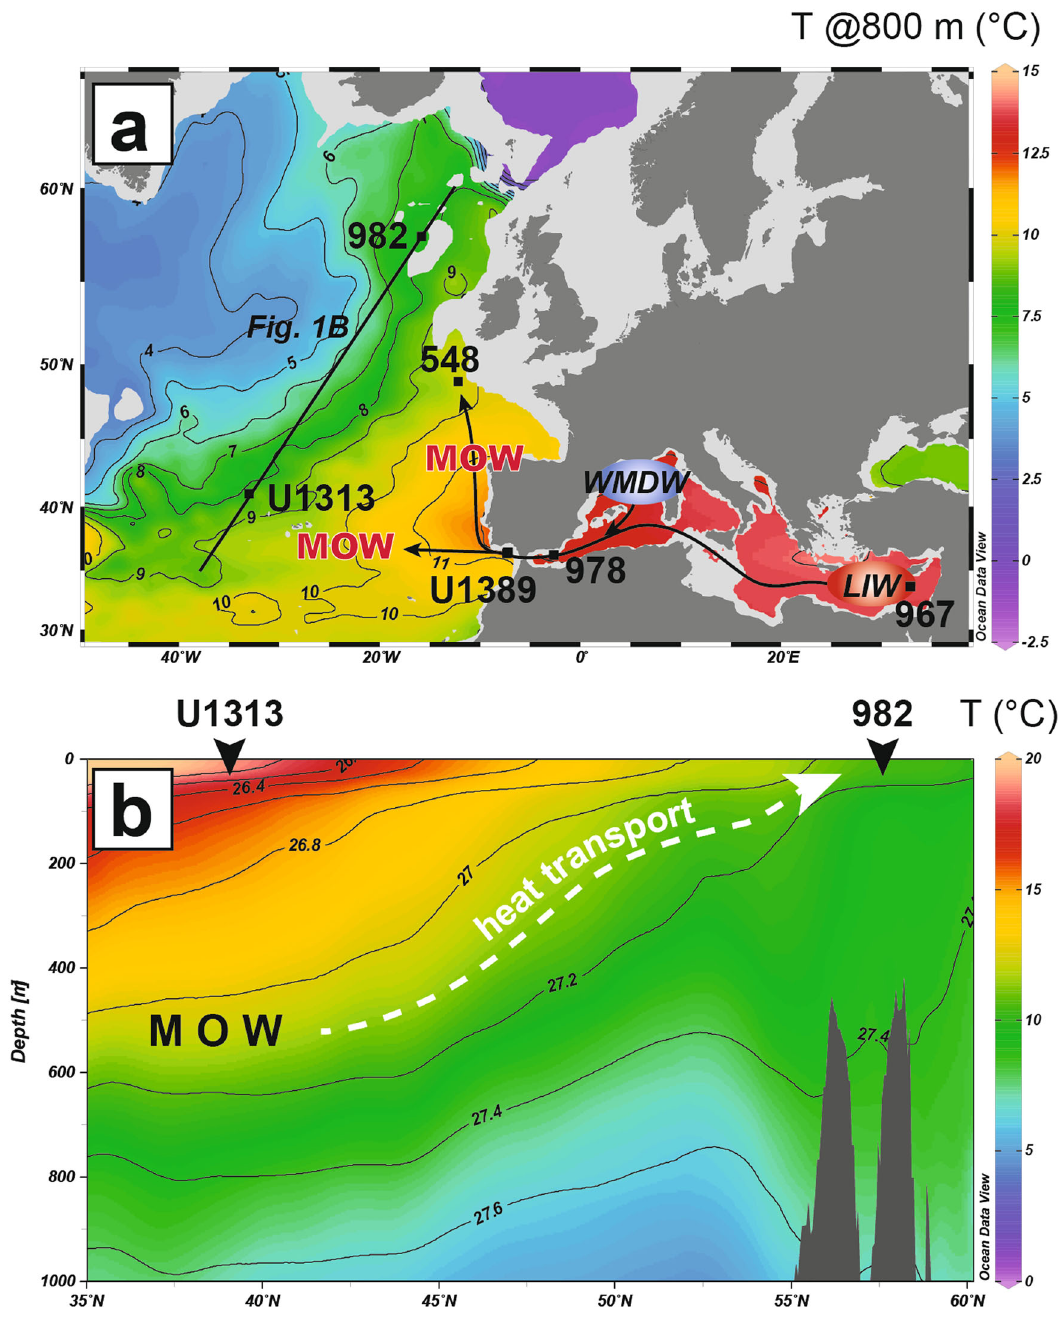
Fig. 2 Hydrography of the North Atlantic and Mediterranean Sea. a Temperatures at 800m water depth in the North Atlantic. Denoted are sites referenced in the text as well as the major fl ow paths of the Levantine Intermediate Water (LIW), Western Mediterranean Deep Water (WMDW) and the Mediterranean Out fl ow Water (MOW) 65 . Hydrographic section displayed in ( b ) is indicated by a black line. b Meridional hydrographic section through Sites U1313 and 982 with temperatures (shading) and isopycnals (kg m − 3 ; contours). The MOW is indicated by a positive temperature anomaly in the deep thermocline at approximately 400 – 1000 m water depth, decreasing upper ocean strati fi cation. The present-day northward trajectory of isopycnal heat transport is indicated by a white dashed